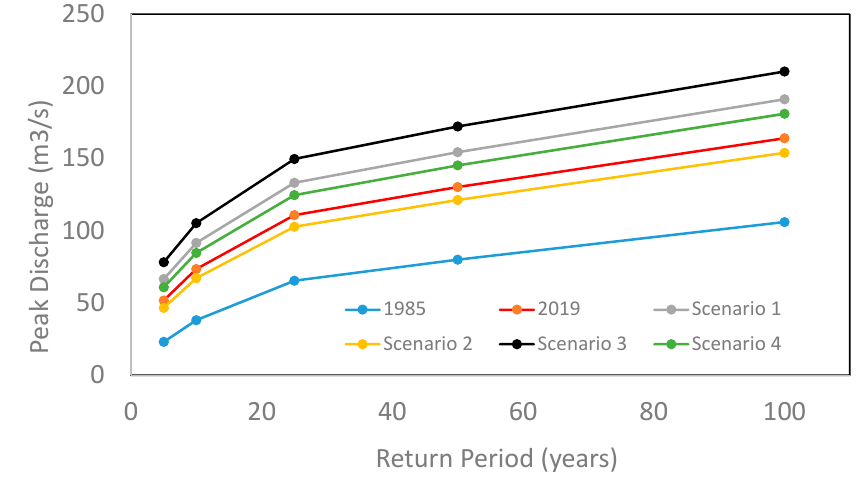
Figure 5. Design peak discharge for Kakia under different LULC scenarios.